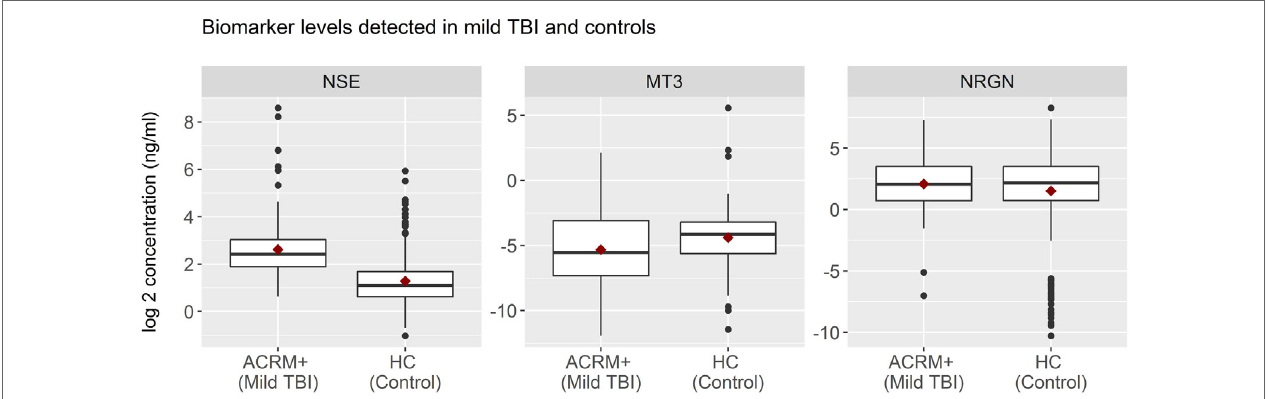
FigUre 2 | Distribution of biomarkers in mild TBI (mTBI) and healthy control subjects. Distribution of biomarker concentrations, analyzed according to TBI status. For each protein marker assay, box plots show log2-transformed detected serum levels for ACRM + mTBI patients (left side of each subplot) versus healthy control subjects (right side of each subplot). The horizontal black lines represent the median of each distribution; red diamonds indicate the mean for the subgroup. Black dots are individual patients with values 1.5 times beyond the interquartile range and are, therefore,